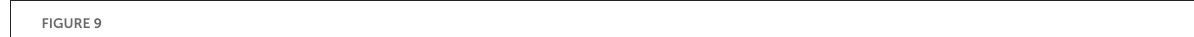
FIGURE9 population A and population B firing rate activity in three different trials where the stimulus is reverted, after 300 ms (left), 700 ms (central), and 900 ms (right). Bottom panels: Corresponding input rates over time. (B) Intensity of stimulus reversal. Top panel: Percentage of choice for population A and population B with a 12.8% coherence stimulus in input that is reverted after 1,000 ms with reverse stimuli at different intensity (–3.2, –6.4, –12.8, –25.6, –51.2, –70, and –80%). Central panels: population A and population B firing rate activity in three different trials where the reverted stimulus intensity is –12.8% (left), –51.2% (central), and –80% (right). Bottom panels: Corresponding input rates over